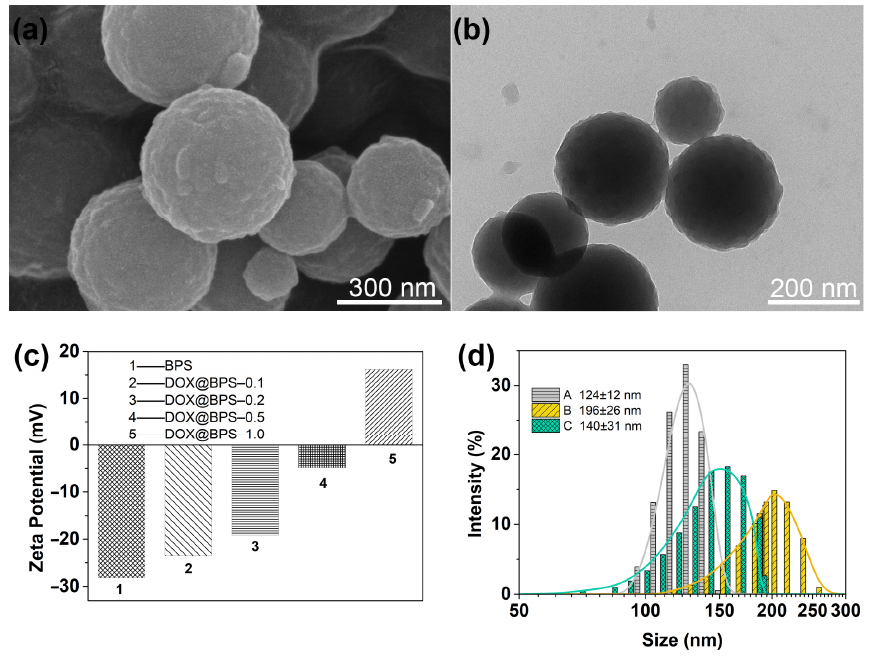
Figure 6. SEM ( a ) and TEM ( b ) micrographs of DOX@BPS; ( c ) zeta potential of DOX@BPS prepared with different feed ratios; ( d ) size of BPS (A), DOX@BPS (B) and DOX@BPS after drug release in PBS buffer solution (pH 7.4) upon light irradiation (C).